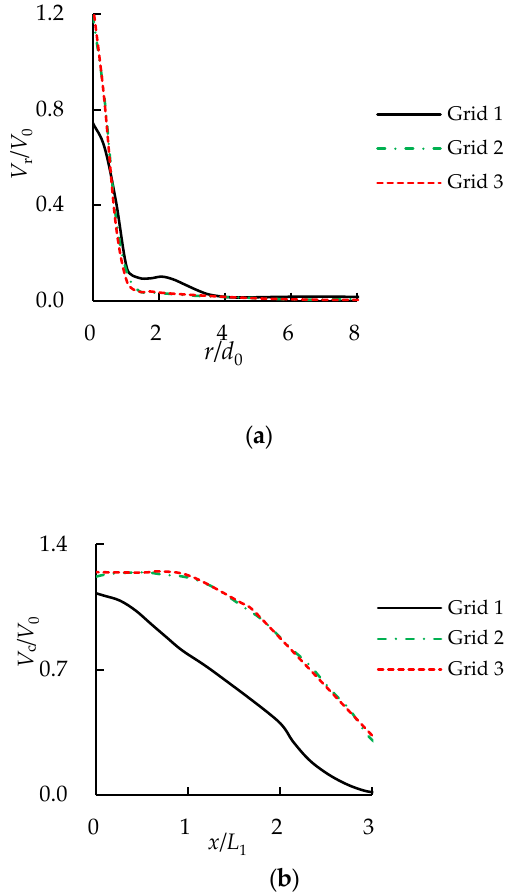
at section x = 2 d 0 and of ( b ) V c / V 0 0